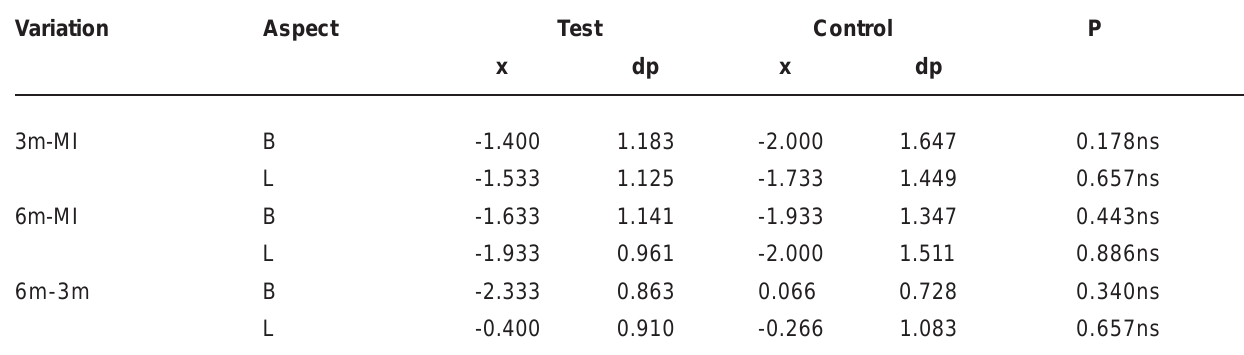
Variation Aspect